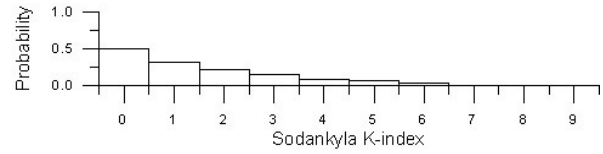
observed, and N t is the total number of analysed intervals.